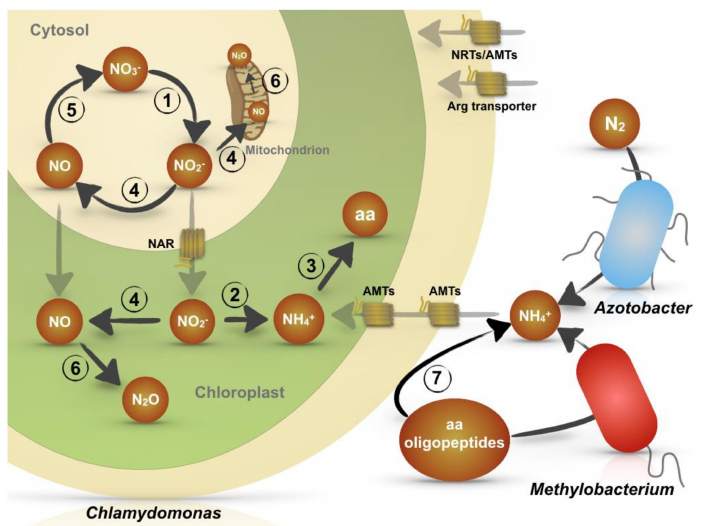
Figure 1. Nitrogen-transforming reactions by Chlamydomonas reinhardtii. NO 3 − assimilation (steps 1,2,3); NO 3 − / NO 3 − cycle, (steps 1,4,5); NO 3 − dissimilation (steps 4,6) and ammonification from amino acids and peptides (step 7). Transporters for ammonium (AMT), nitrate (NRT), and arginine are indicated. Mutualism with bacteria for N / C exchange is also